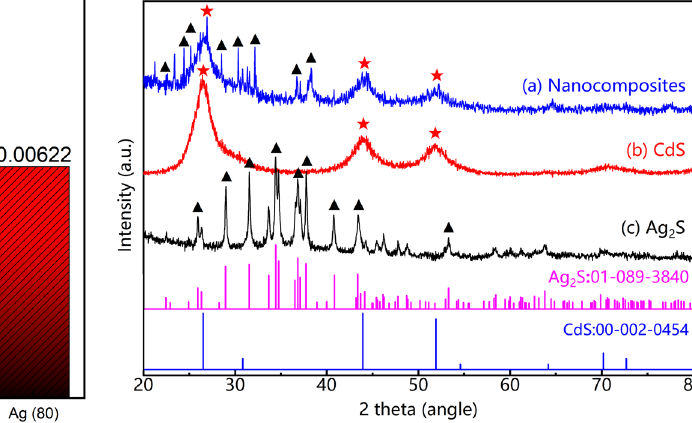
Figure 2: Rate constant ( k ) of photolysis of di ff erent M - thiosulfate by UV - C ( Cd – Ag thiosulfate; Ag – thiosulfate; Cd – thiosulfate ) .